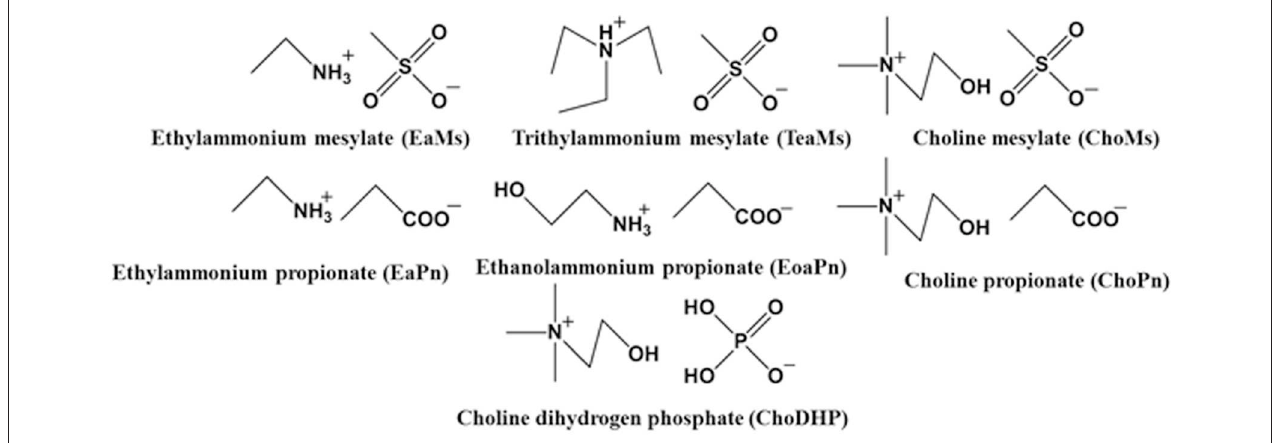
FIGURE 1 | Structure of ionic liquids used in this study.